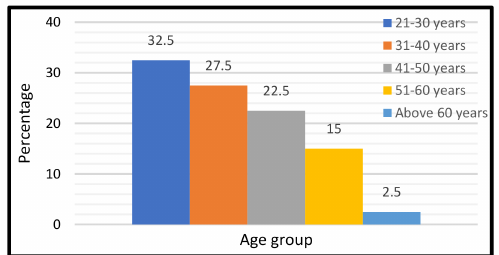
Figure 1. Age distribution of the vegetable seed sellers.